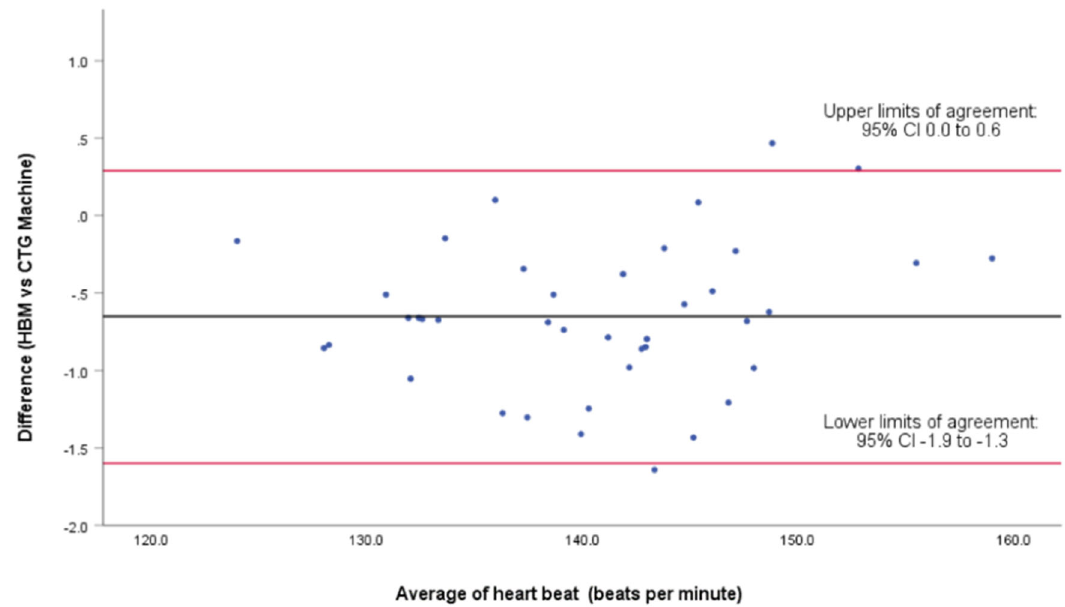
Fig. 4 Bland-Altman plot. Difference in heart rate (beats per minute) between 40 pairs of cardiographs recorded by the fetal heartbeat monitor with-belt stabilisation, and cardiotocography. Table 3. System Usability Scale Results of Women who used heartbeat monitor unsupervised at home (phase